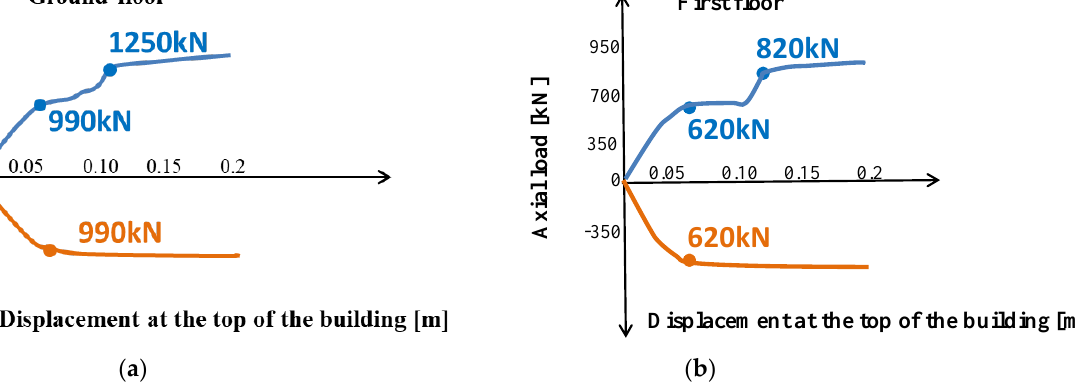
Figure 13. Axial load – displacement curves for the steel diagonal braces of RD1 in x-x direction: (a) ground floor and (b) first floor.